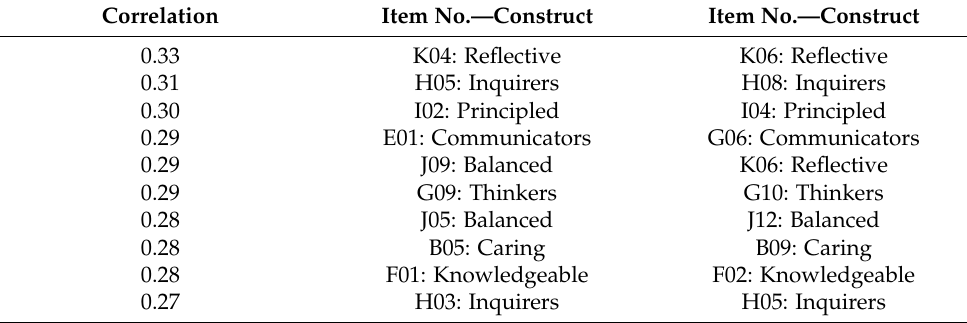
Table 3. List of local items